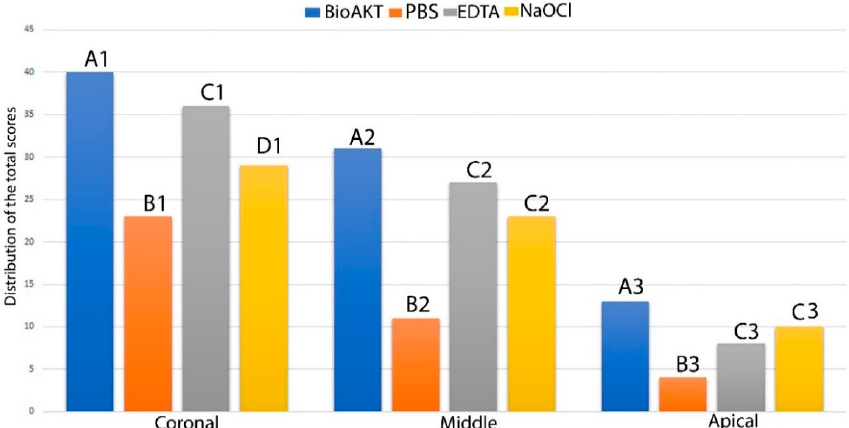
Figure 4. Graph showing the distribution of the scores for sealer penetration (score 0–3) obtained during the confocal microscopy assessment for each treatment at different root canal level; the higher the total value the greater the ability to remove smear layer. Similar letter indicates no significance between the irrigants in each third level of the root. Similar number indicates no significance between the same irrigant in a different third level.